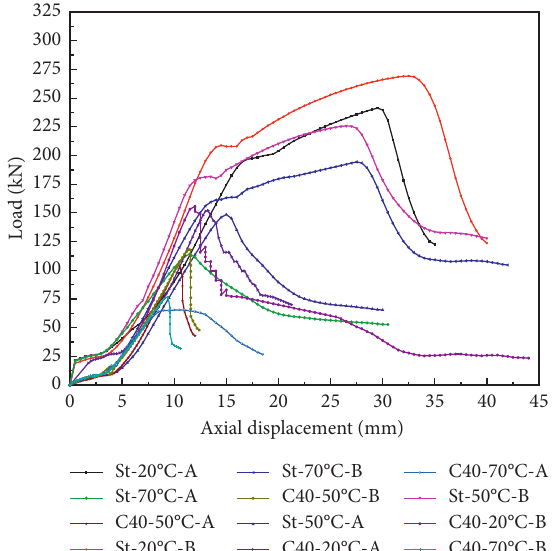
Figure 15: Relationship between drawing force and